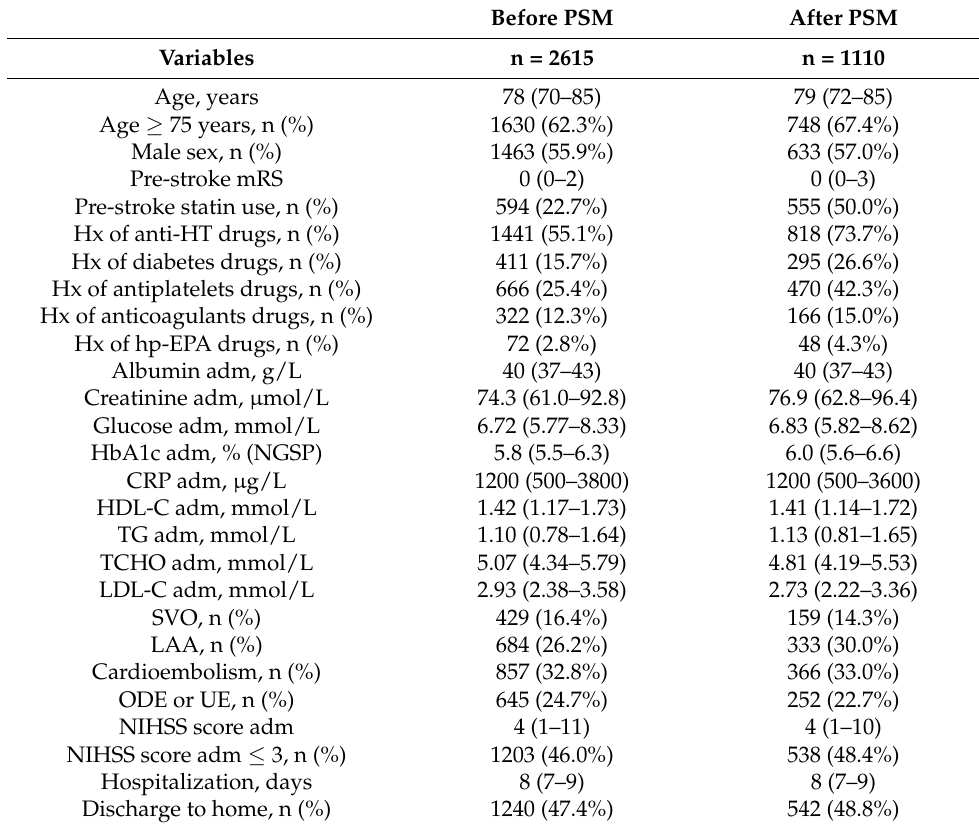
Figure 1. Flow chart of the patient selection process. PSM, propensity score matching. Table 1. Patients’ characteristics before and after propensity score matching.